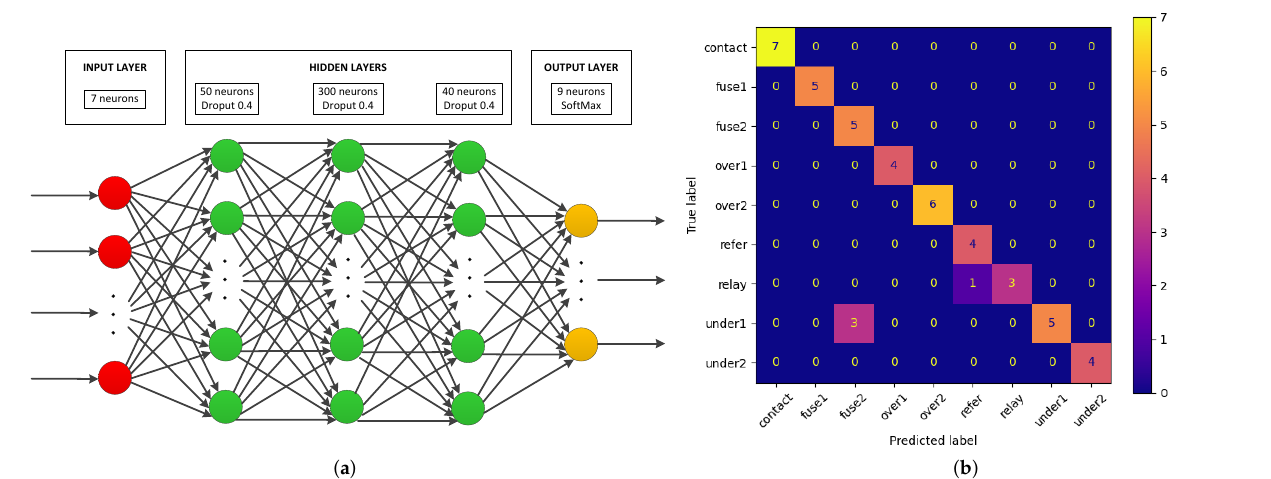
Figure 7. Predictive model implemented in the MANTRA system: ( a ) architecture of the ANN; ( b ) confusion matrix obtained with a fold of the training